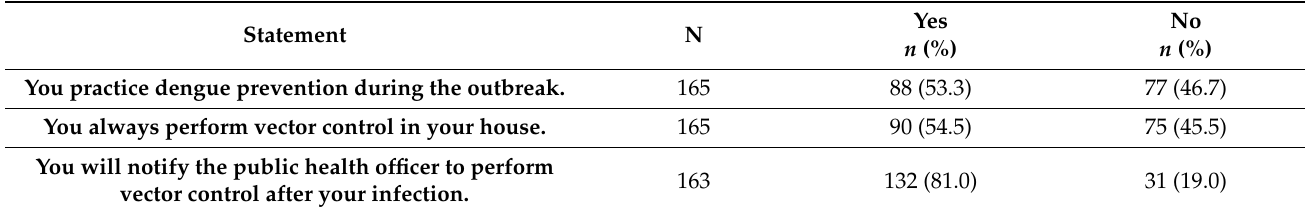
Table 4. Practices for preventing dengue infection.